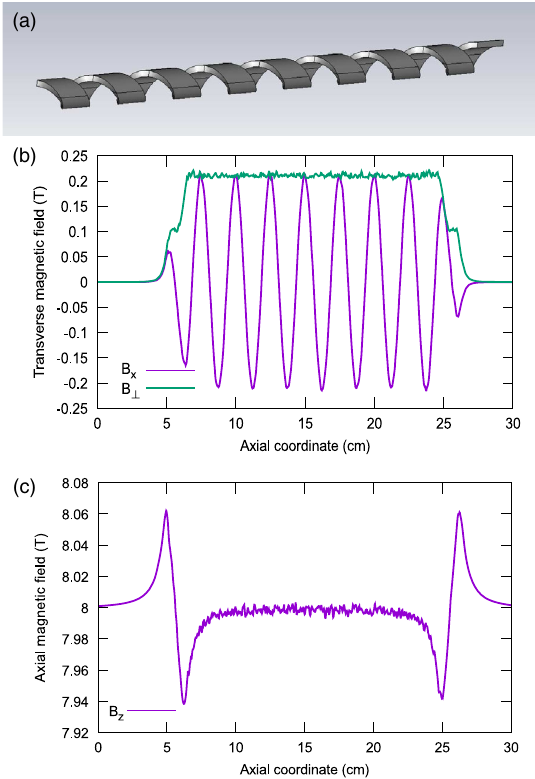
FIG. 2. Results of simulations within the CST Studio for the case of steel helix with rectangular cross section having the parameters of d ¼ 2 . 5 cm, a ¼ 1 . 2 cm, R 1 ¼ 0 . 3 cm and b ¼ 0 . 2 cm. The helix geometry (a) and the amplitudes of the transverse (b) and axial (c) magnetic fields.